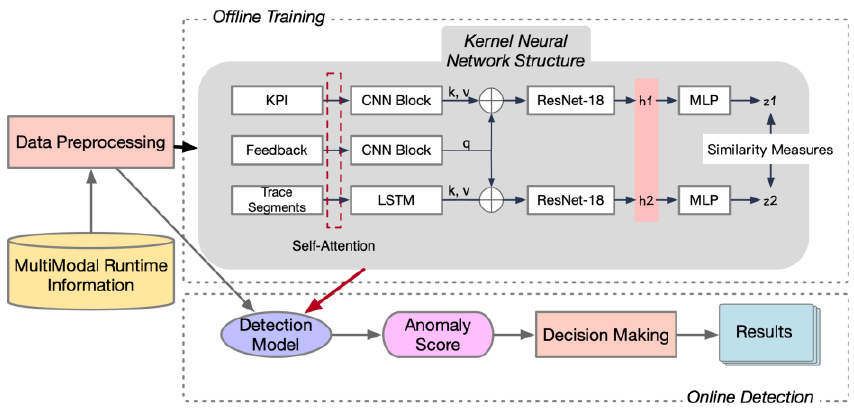
Figure 3. The overall framework of